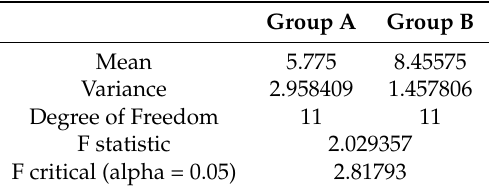
Figure 10. Boxplot for the standard deviation of heart rate. Table 5. Key statistics of the student action